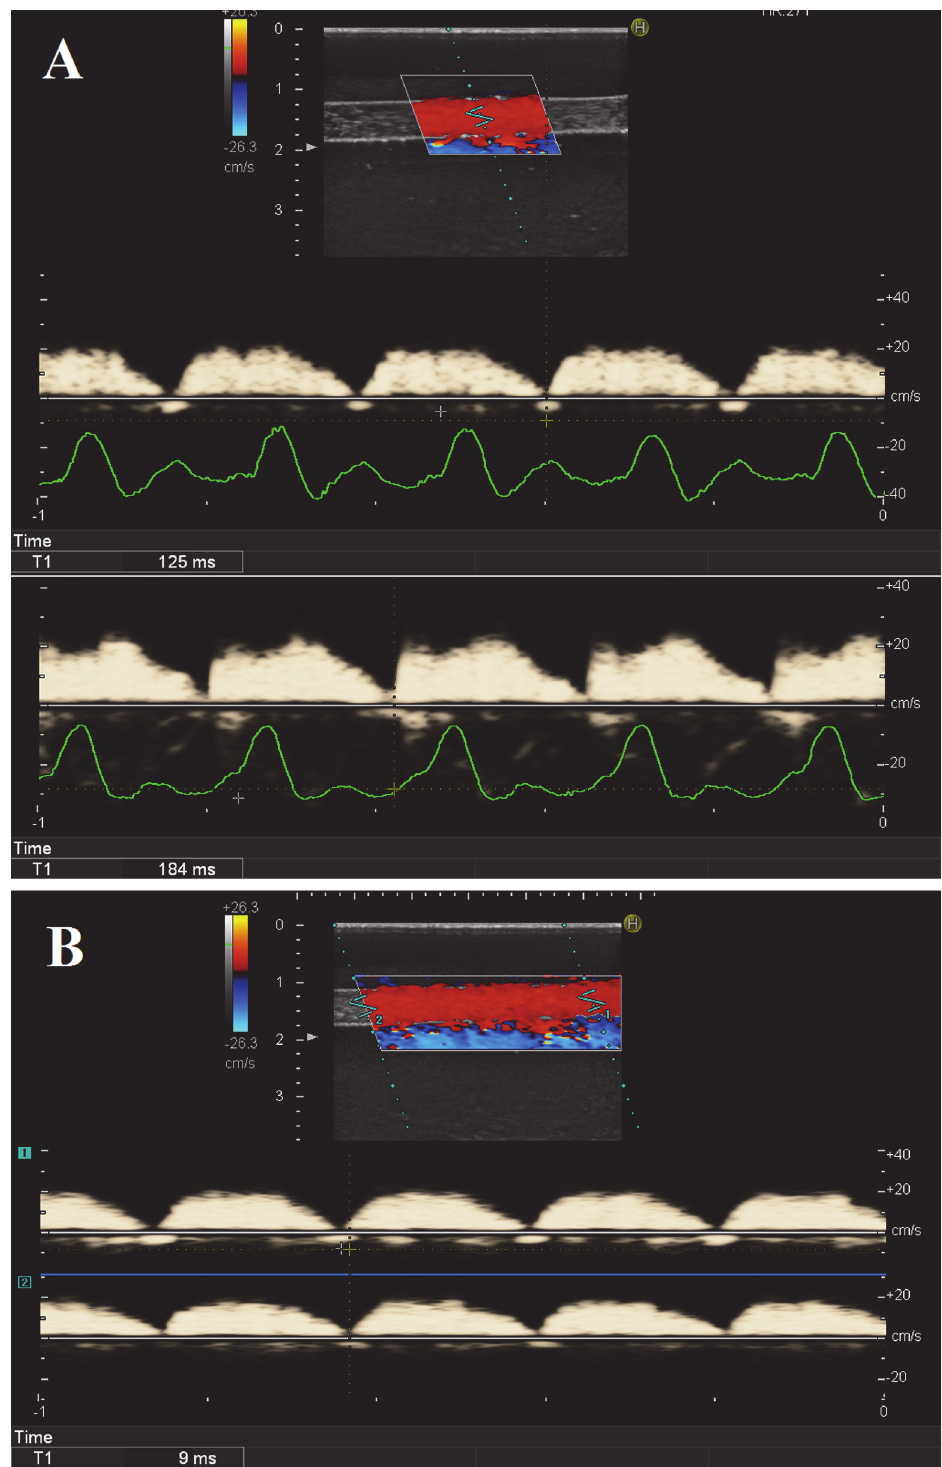
Fig 2. The methodology of the in vitro study. Panel A, the PWV A-B measurement, the top panel was the two dimensional echocardiographic imaging. The velocity spectra recorded at point A and B by pulse wave Doppler were displayed at the middle and bottom, respectively. The pressure curve recorded by the pressure transducer was shown under each spectrum. The time delay between the transducer and point A and B